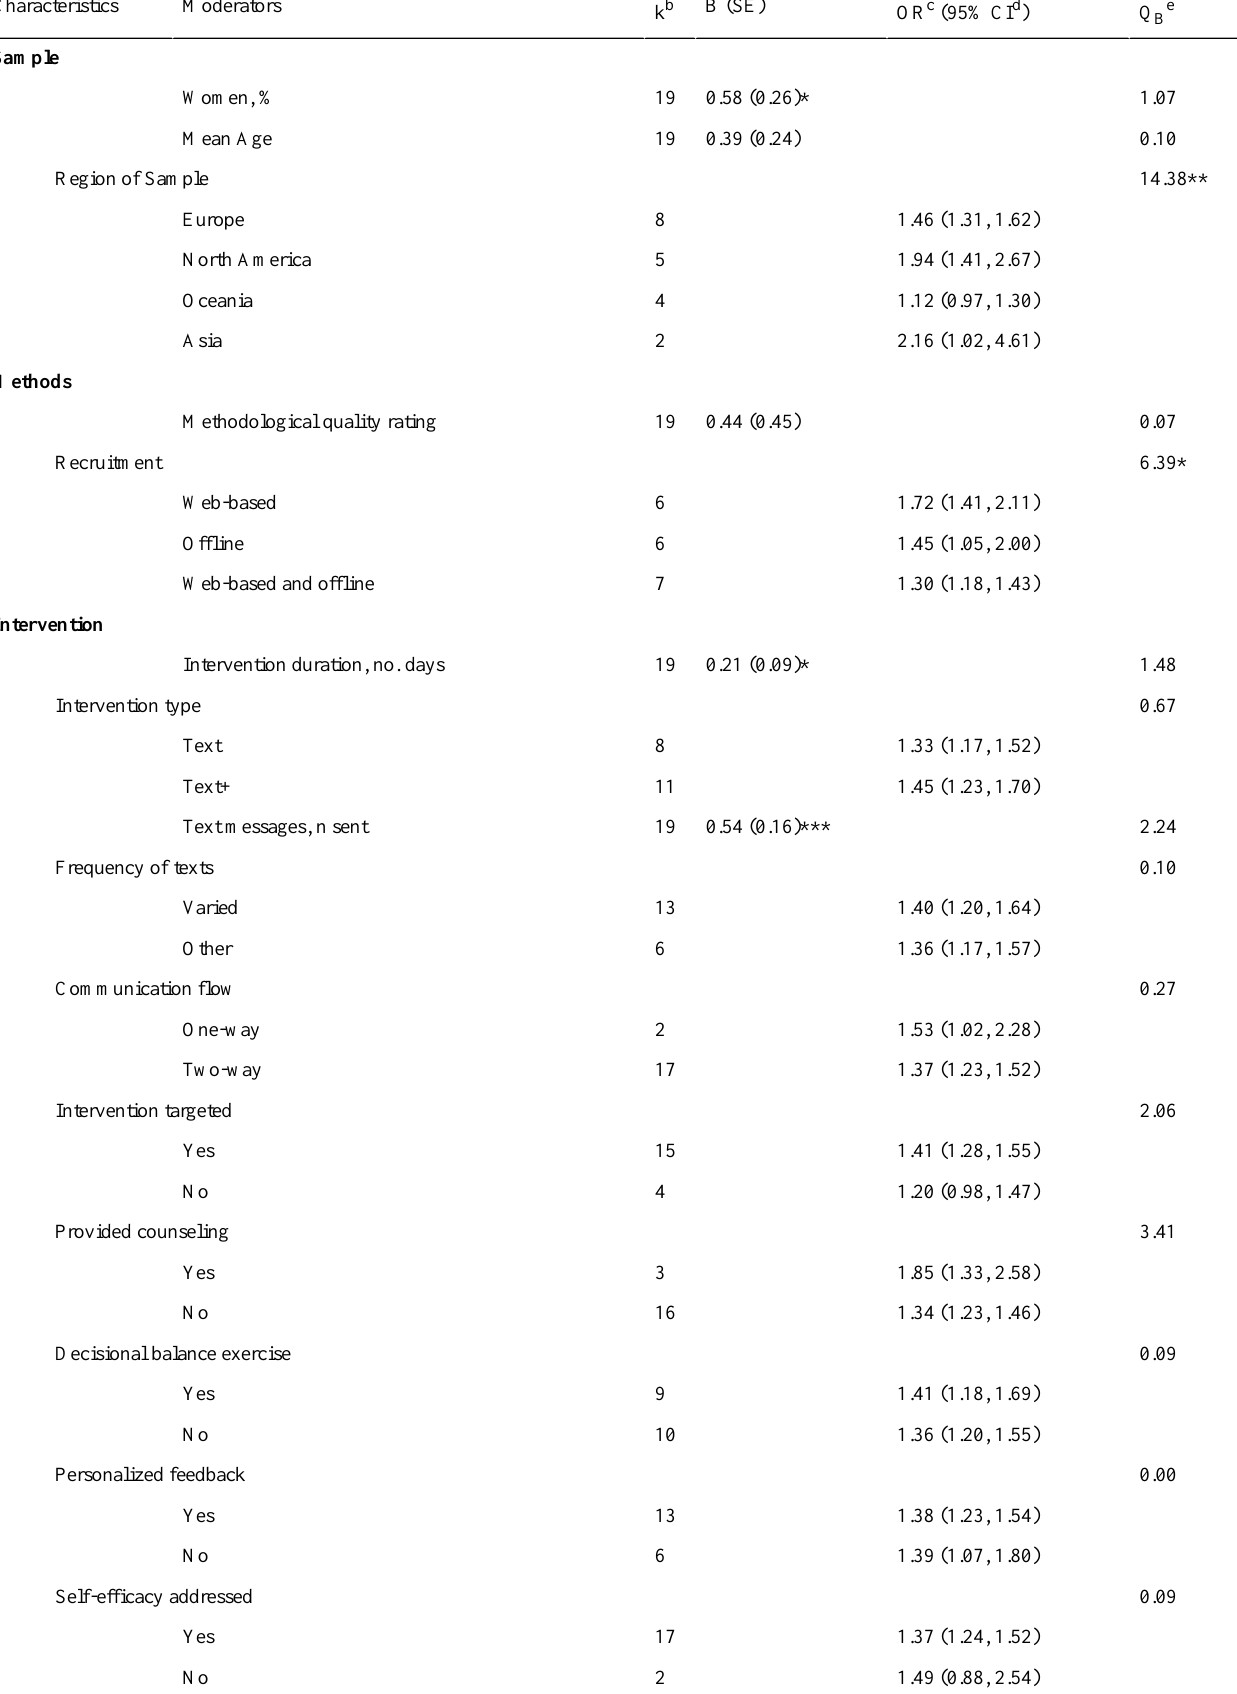
Table 4. Moderators of overall smoking abstinence at the final available assessment.